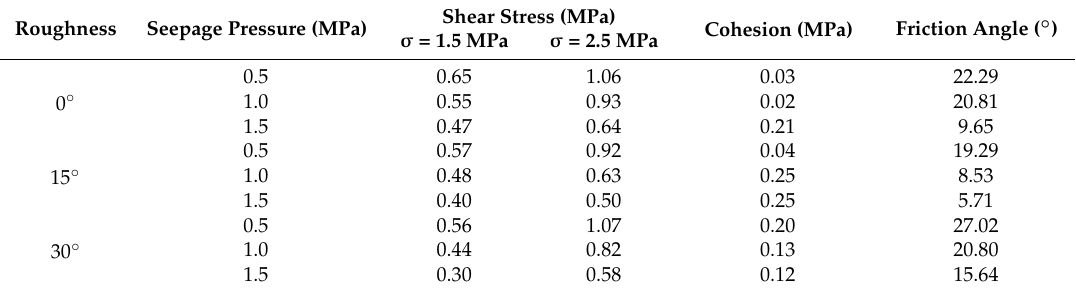
Table 3. Shear strength parameters of joint samples with different roughness and seepage pressures. Roughness Seepage Pressure (MPa)